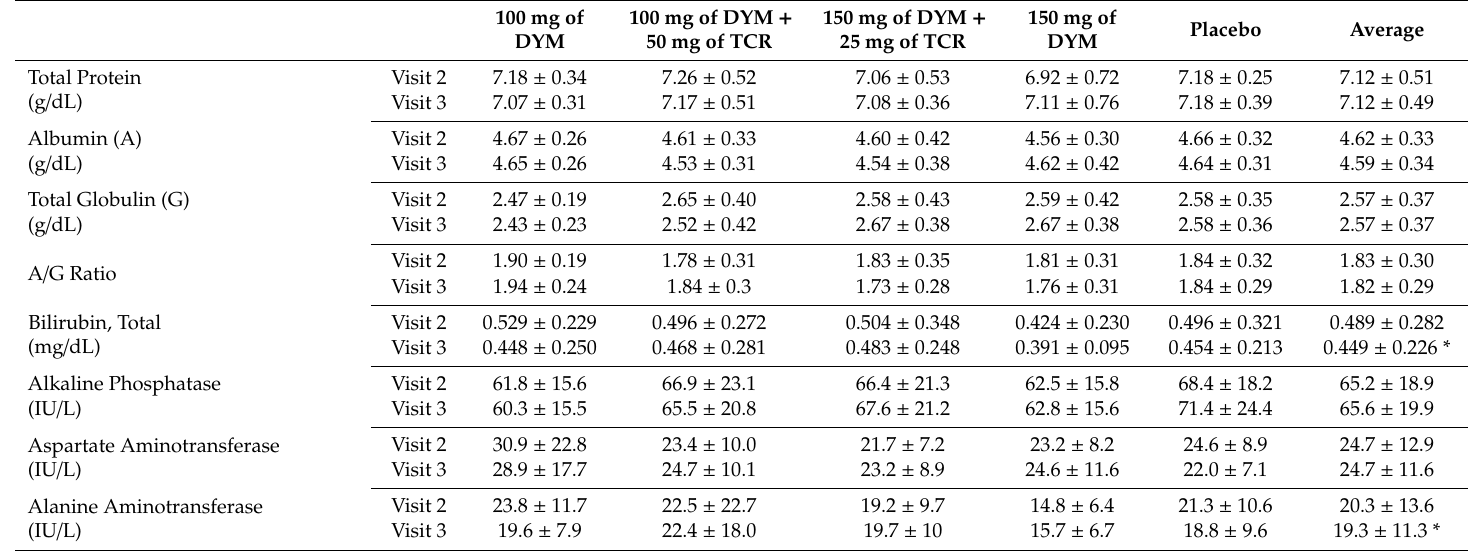
Table 6. Group ( n = 25 per group) and average complete metabolic panel comparisons between Visits 2 and